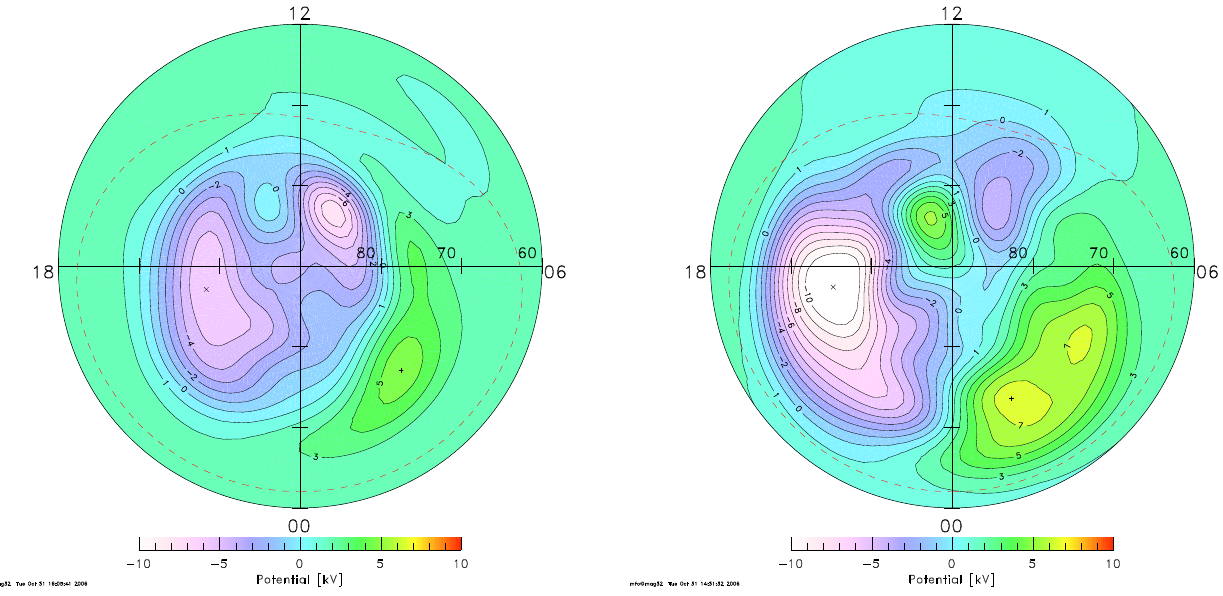
Fig. 14. Potential patterns for northward IMF and two levels of nighside activity. Left: Low values of ASYM-H < 20nT, indicating little or no auroral activity. Right: High ASYM-H values ( ≥ 20nT), indicating strong partial ring current activity. The full Quadrant 0 of clock angle distribution, i.e. ± 45 ◦ centered around 0 ◦ , and North and South Hemisphere combined have been used to derive the potential maps.